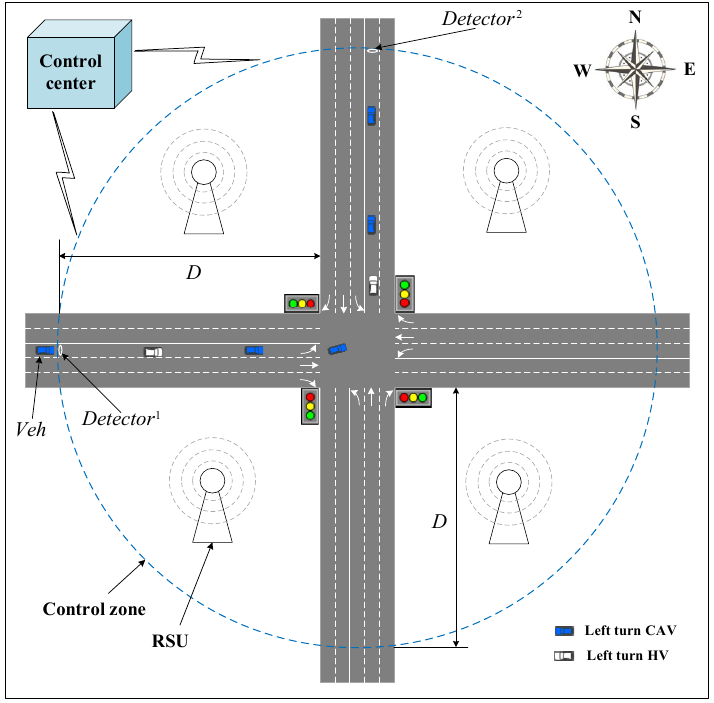
Figure 1. The road network structure.